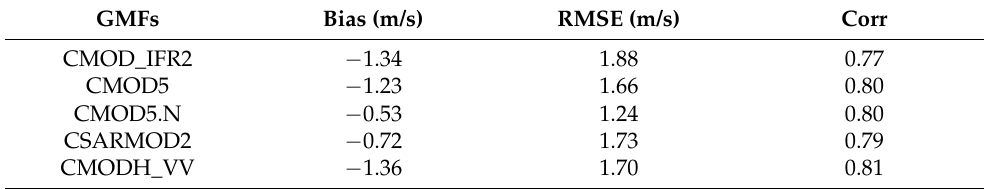
Figure 4. Comparison of wind speed retrieval results from GF3-02 VV polarization data based on ( a ) CMOD_IFR2, ( b ) CMOD5, ( c ) CMOD5.N, ( d ) CSARMOD2, and ( e ) CMODH_VV and ERA5 wind data. Table 3. Comparison of wind speed retrieval results of the GF3-02 VV polarization data based on each GMF model and HY-2B SCA wind